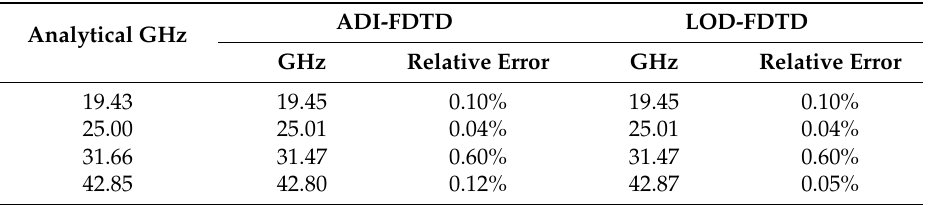
Table 4. Comparison of the results of the ADI-FDTD and 3D LOD-FDTD methods. Analytical GHz